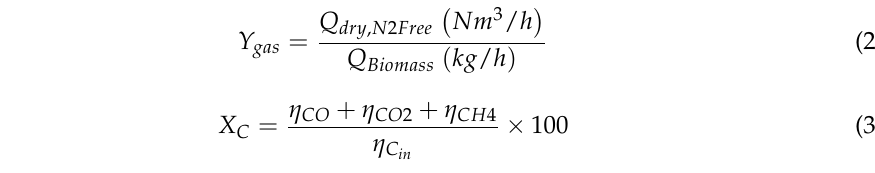
Table 4. Experimental results.